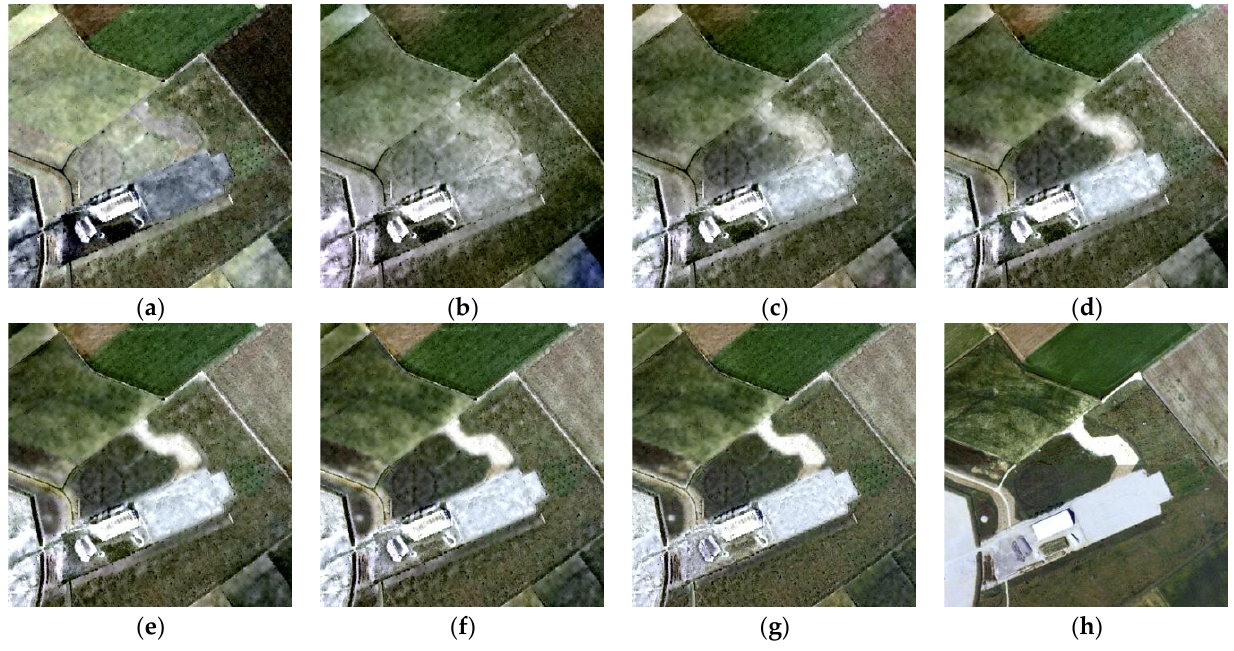
Figure 9. Fusion results of adjustability experiment in area 1. ( a ) IHS fusion; ( b ) LPSR-5; ( c ) LPSR-4; ( d ) LPSR-3; ( e ) LPSR-2; ( f ) LPSR-1; ( g ) LP-based fusion; ( h ) original HR multispectral